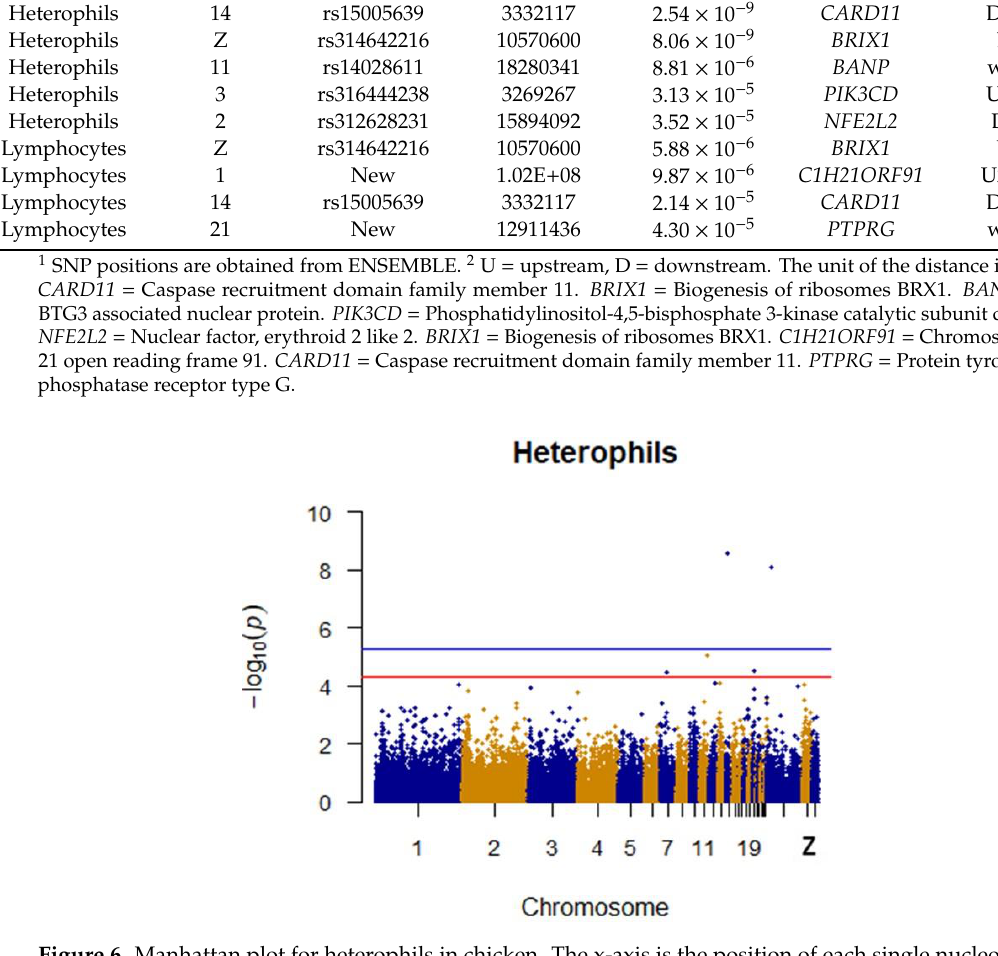
Figure 6. Manhattan plot for heterophils in chicken. The x-axis is the position of each single nucleotide polymorphism (SNP) on the chicken chromosomes 1–28 and linkage group and the y-axis is the − log10 p -value.